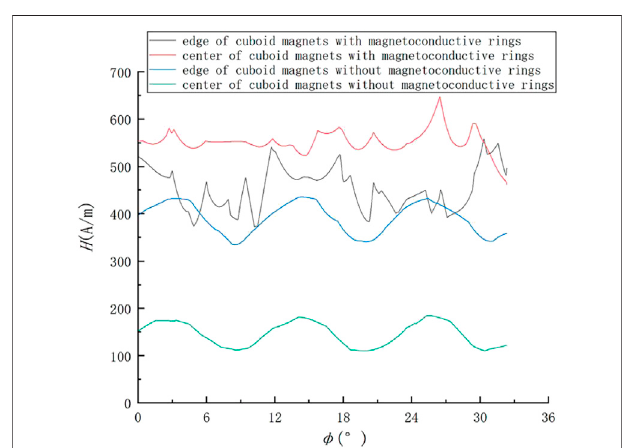
FIGURE 13 | Results of the static seal capacity